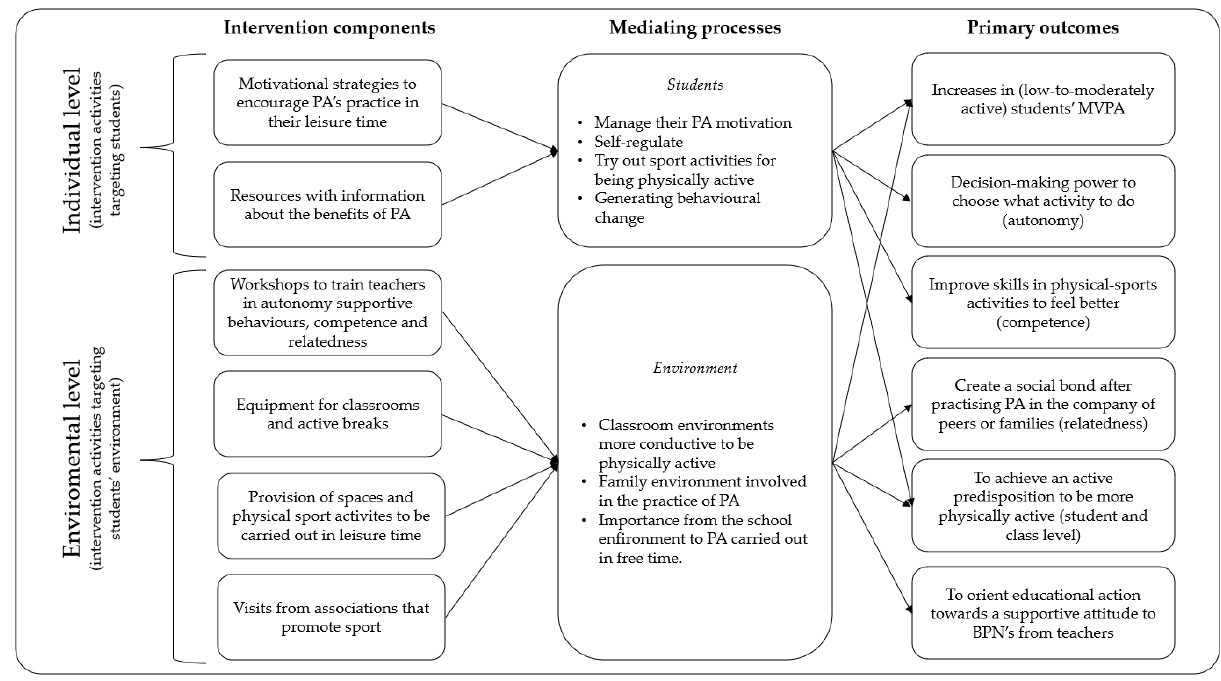
Figure 2. Streamlined coherent model linking intervention components to hypothesised mediating processes and primary outcomes.